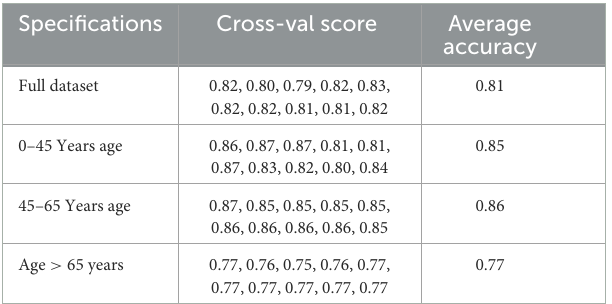
TABLE 6 Random forest model cross validation